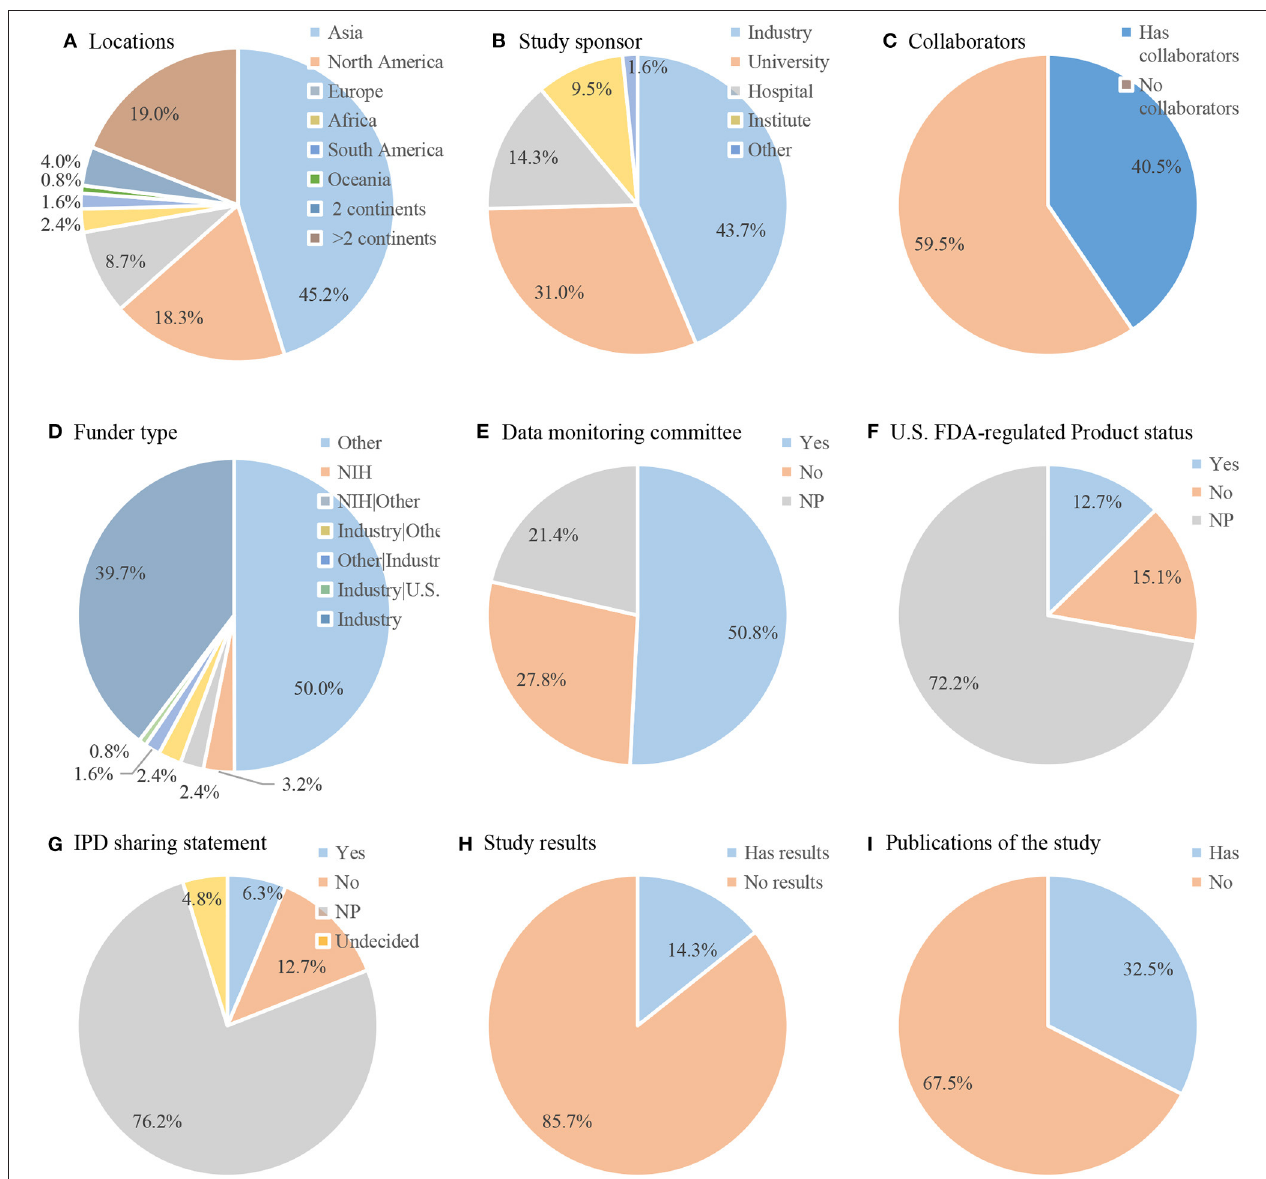
FIGURE 4 | Detailed characteristics of included trials ( n = 126). Pie chart of (A) locations; (B) study sponsor; (C) collaborators; (D) funder type; (E) data monitoring committee; (F) U.S. FDA-regulated Product status; (G) IPD sharing statement; (H) Study results; (I) Publications of the study. IPD, Individual Participant